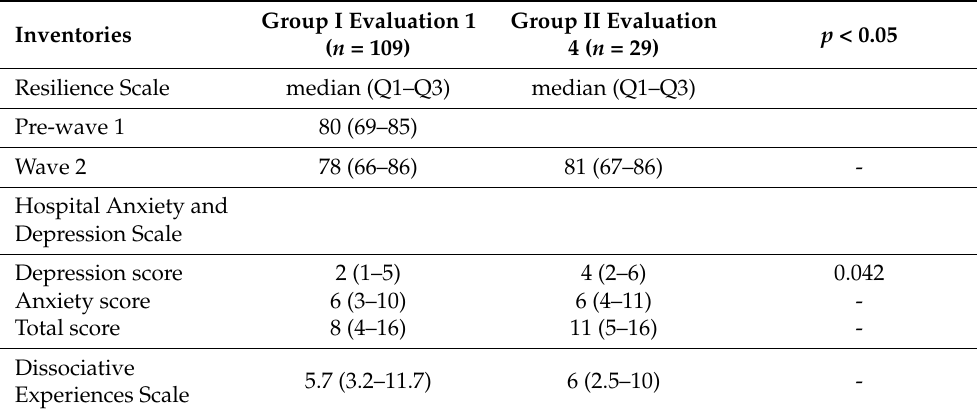
Table 1. Median and quartiles 1 and 3 (Q1–Q3) of the total score of the Resilience Scale, the Hospital Anxiety and Depression Scale (HADS), and the Dissociative Experiences Scale at the time of inclusion in the study, either at the first epidemic wave (Group I) or at the second epidemic wave (Group